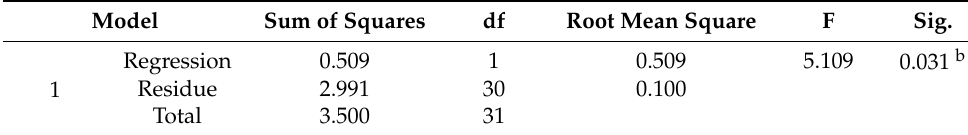
Table 5. Statistical Analysis ANOVA a .